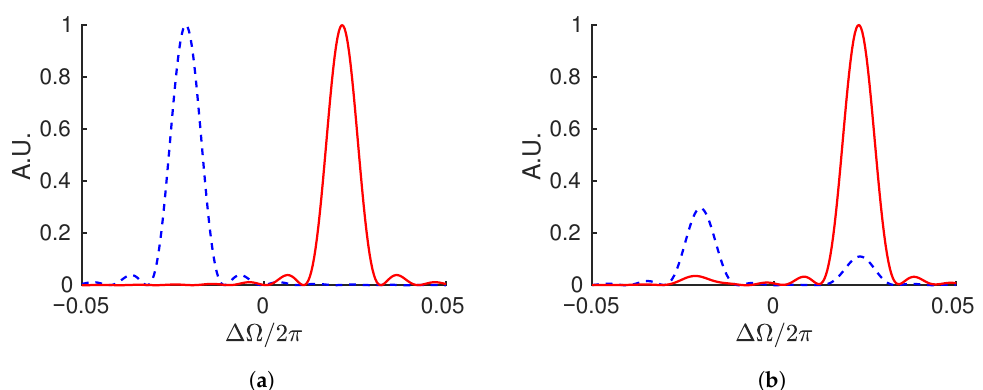
Figure 4. Numerical solution showing a pair of teeth of the two frequency combs (red,blue) defined by Equation (21) after 100 round-trips with no coupling, s = 0 ( a ), and coupling, s = 0.1 e ( 1 i ) ( b ). Both simulations were carried out with a detuning of ∆ ϕ = 0.27, gain of α 0 = 1, β = 0.05, and W s = 1 in Equation (8), and τ p = 1. When coupling is included, the fields pass energy back and forth such that which field is dominant in plot ( b ) depends on how many round-trips are